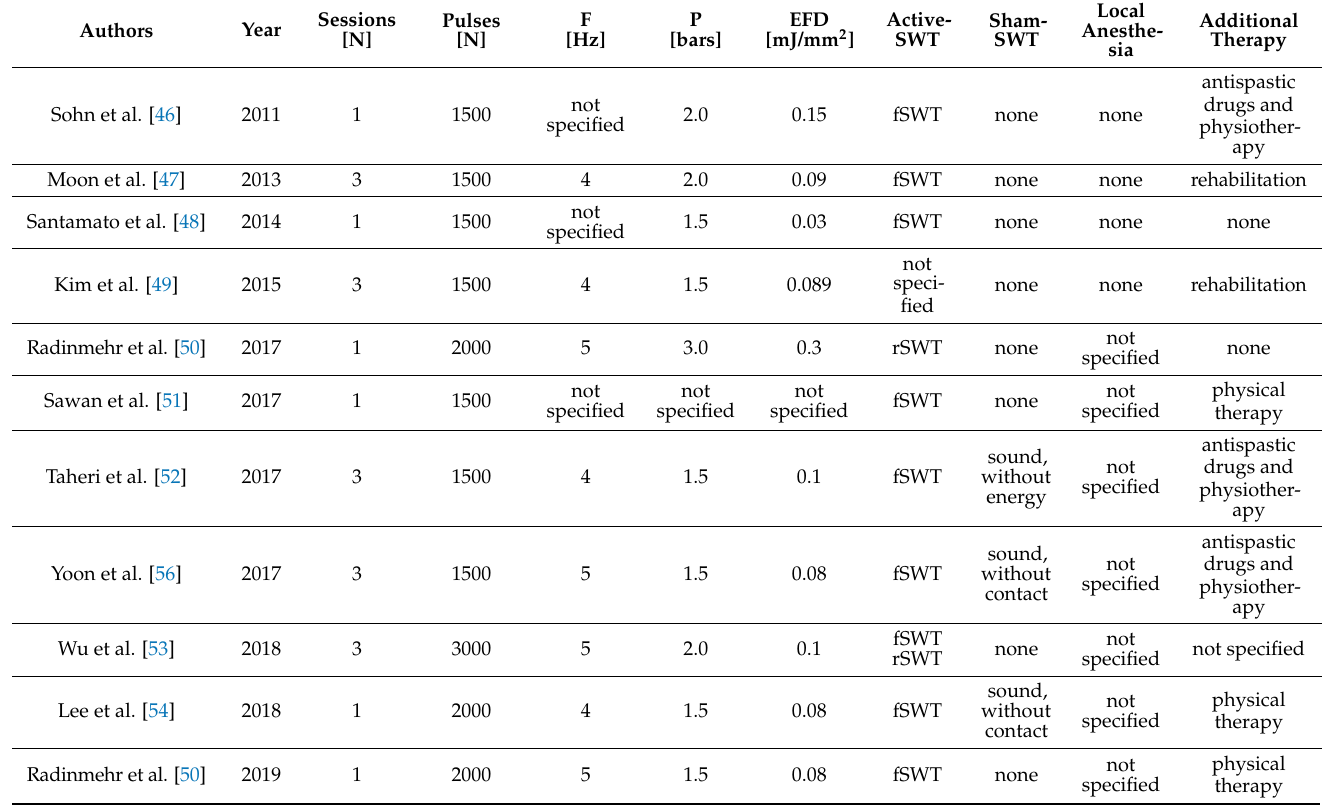
Table 5. Lower limb—characteristics of SWT procedure and treatments.